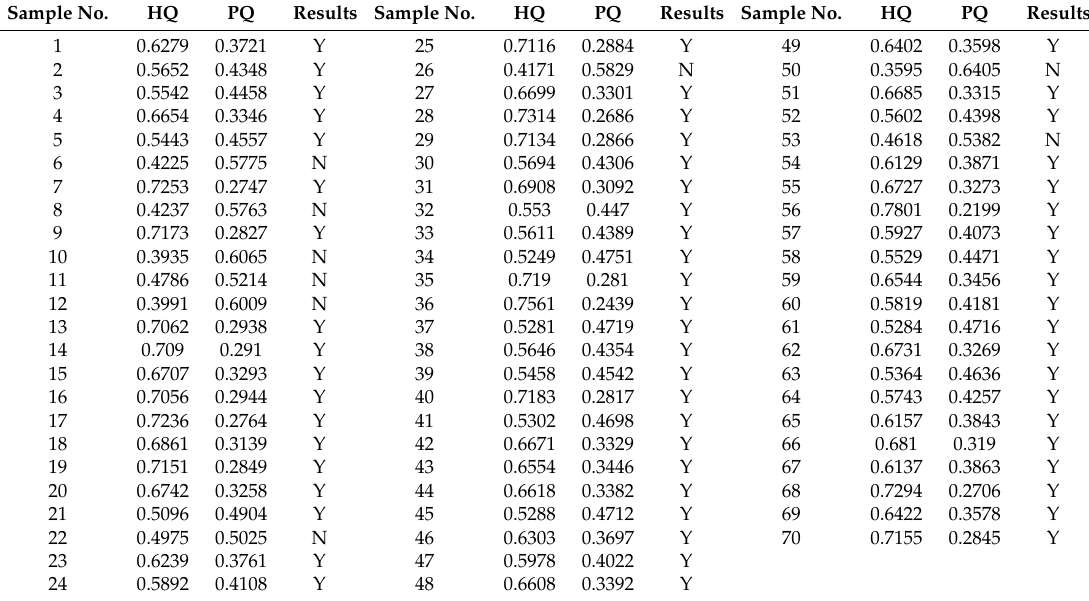
Table 5. Matrix of the grade of membership for the samples. Sample No.